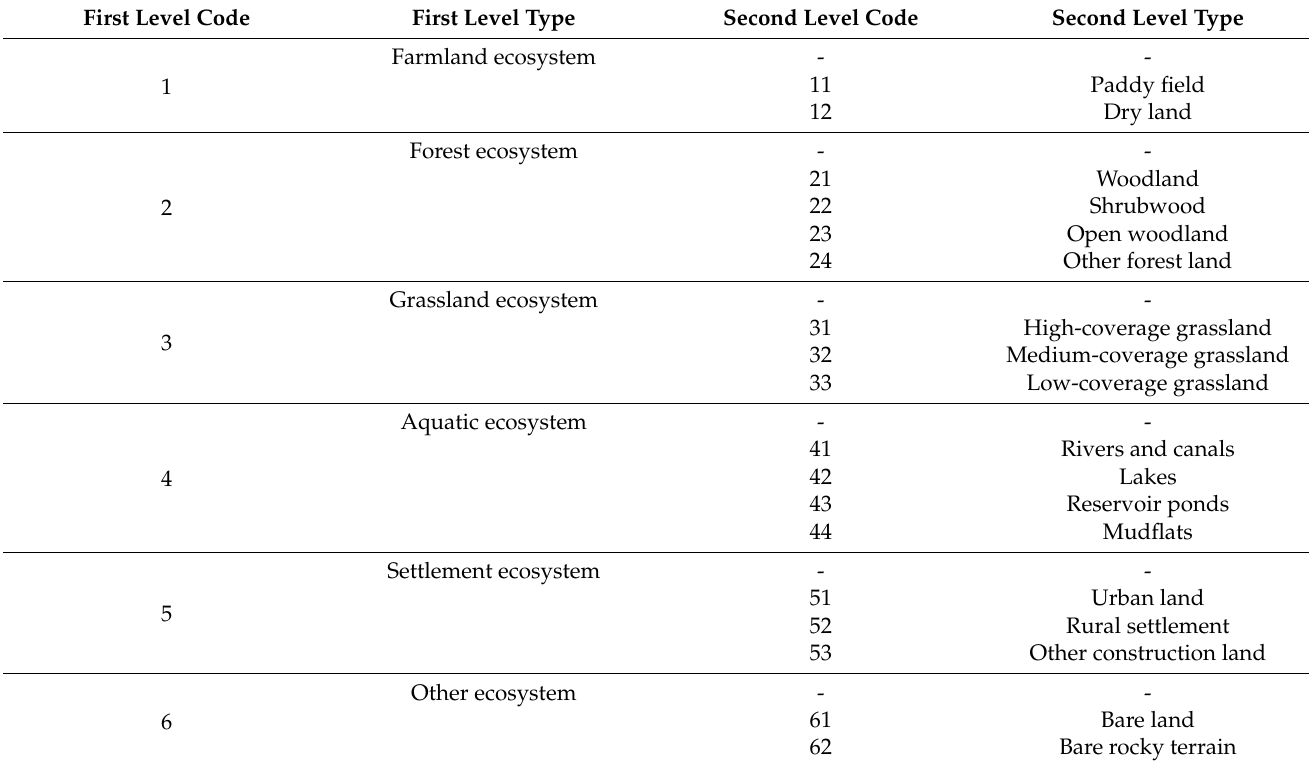
Table 1. Classification system of the Guizhou terrestrial